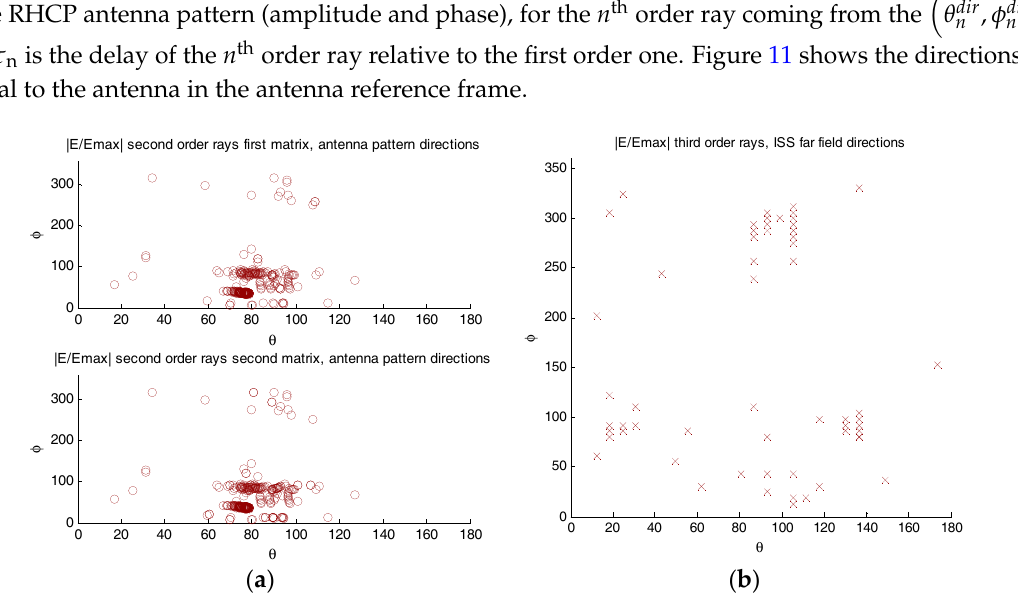
Figure 11. ( a ) Second order arriving direction to GEROS-ISS in the antenna reference frame, and ( b ) third order rays arriving direction to GEROS-ISS in the ISS far field reference frame. Top: first matrix and bottom: second matrix, refer to the fact that there are second order and third order rays that have the same far field direction, but enter through different directions in the antenna pattern reference frame. Color code corresponds to the delay in ns.